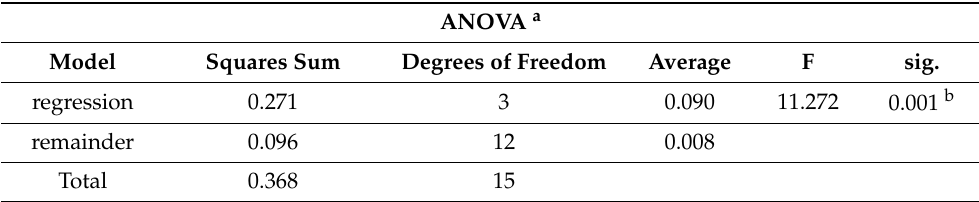
Table 11. Analysis of variance for strain model of CDWRCon.